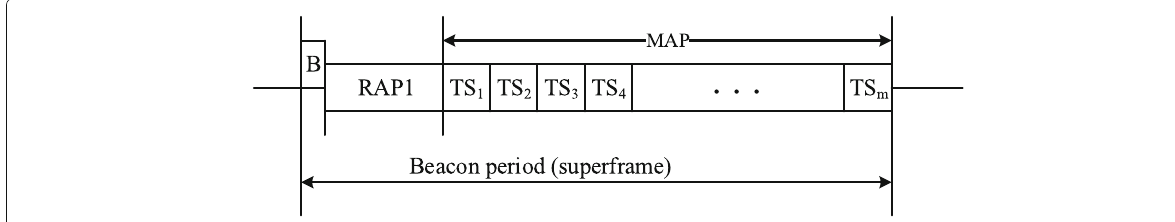
Fig. 6 Superframe